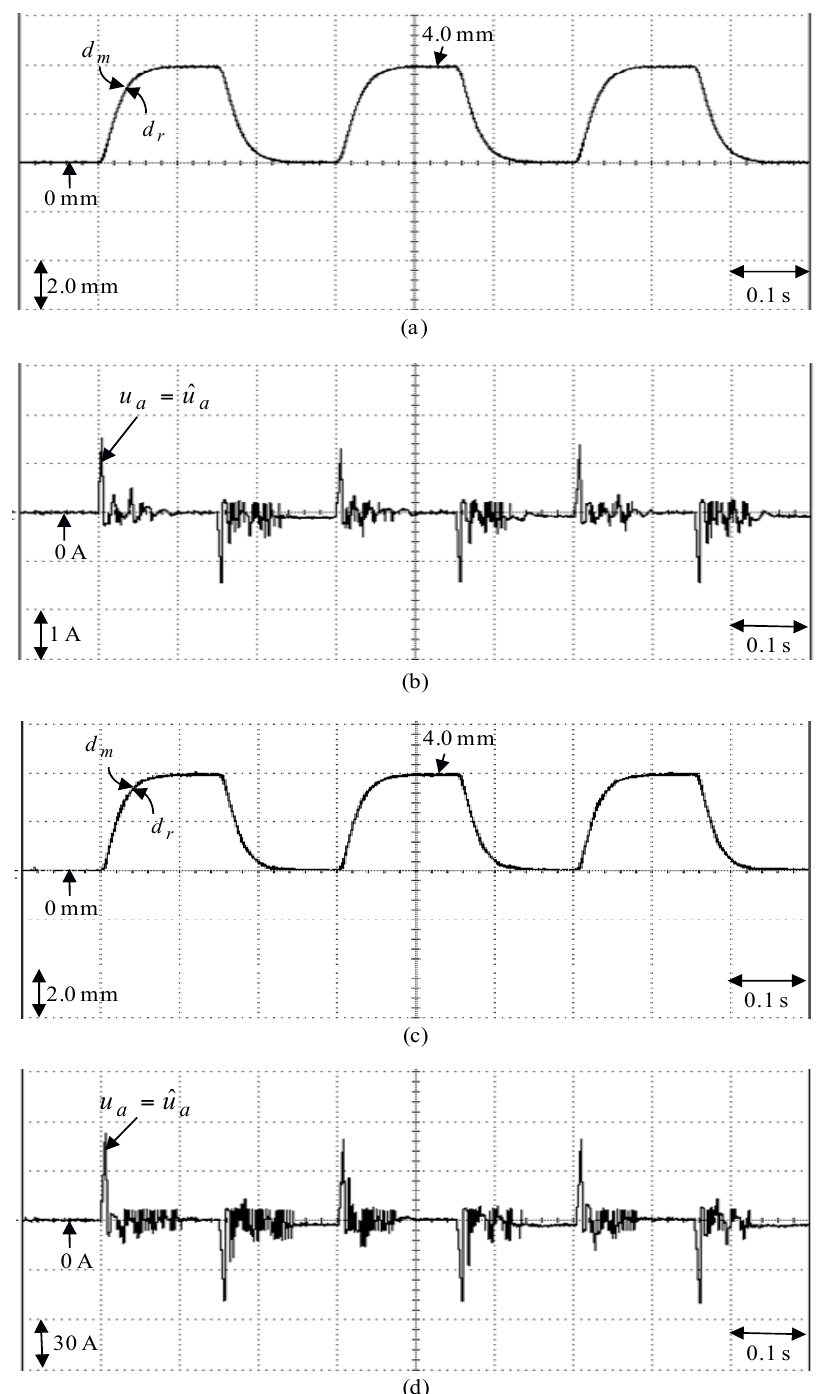
Figure 15. Experimental results of the proposed AAENNB control system due to periodic step command from 0 mm to 4.0 mm: ( a ) position reaction of the mover in Case 1, ( b ) reaction of control effort in Case 1, ( c ) position reaction of the mover in Case 2, ( d ) reaction of control effort in Case 2.